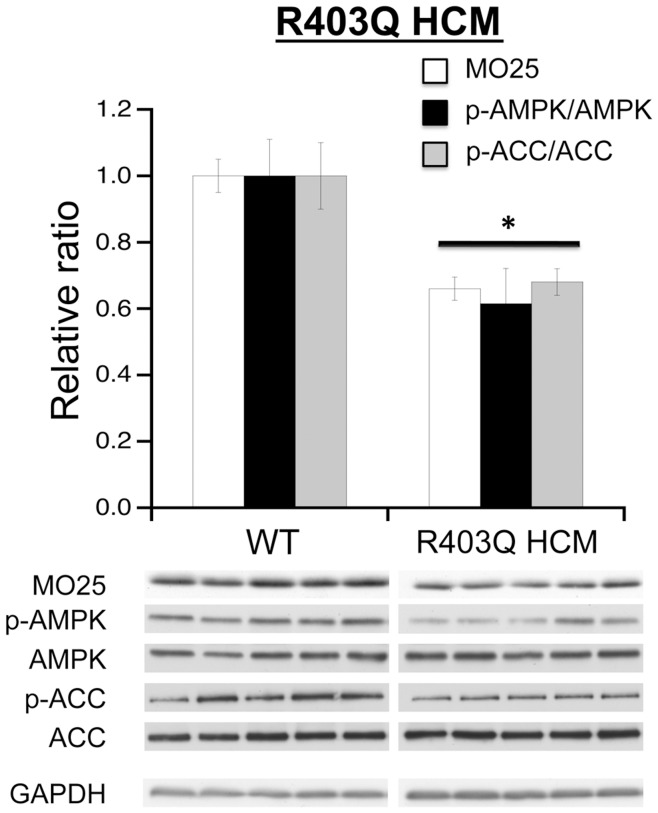
Modification of AMPK signaling axis in R403Q HCM hearts.Bar graph summary (top panel) of Western blots (bottom panel) for MO25, AMPK, phosphorylated AMPK (p-AMPK), ACC and p-ACC using left ventricular lysates from 60 day male WT or R403Q HCM hearts. Each bar indicates mean values ± S.E.M. (n = 6 hearts) and represents ratio of total protein to GAPDH or phosphorylated protein to each respective level of total protein following normalization to GAPDH. *P<0.05 compared to WT controls.